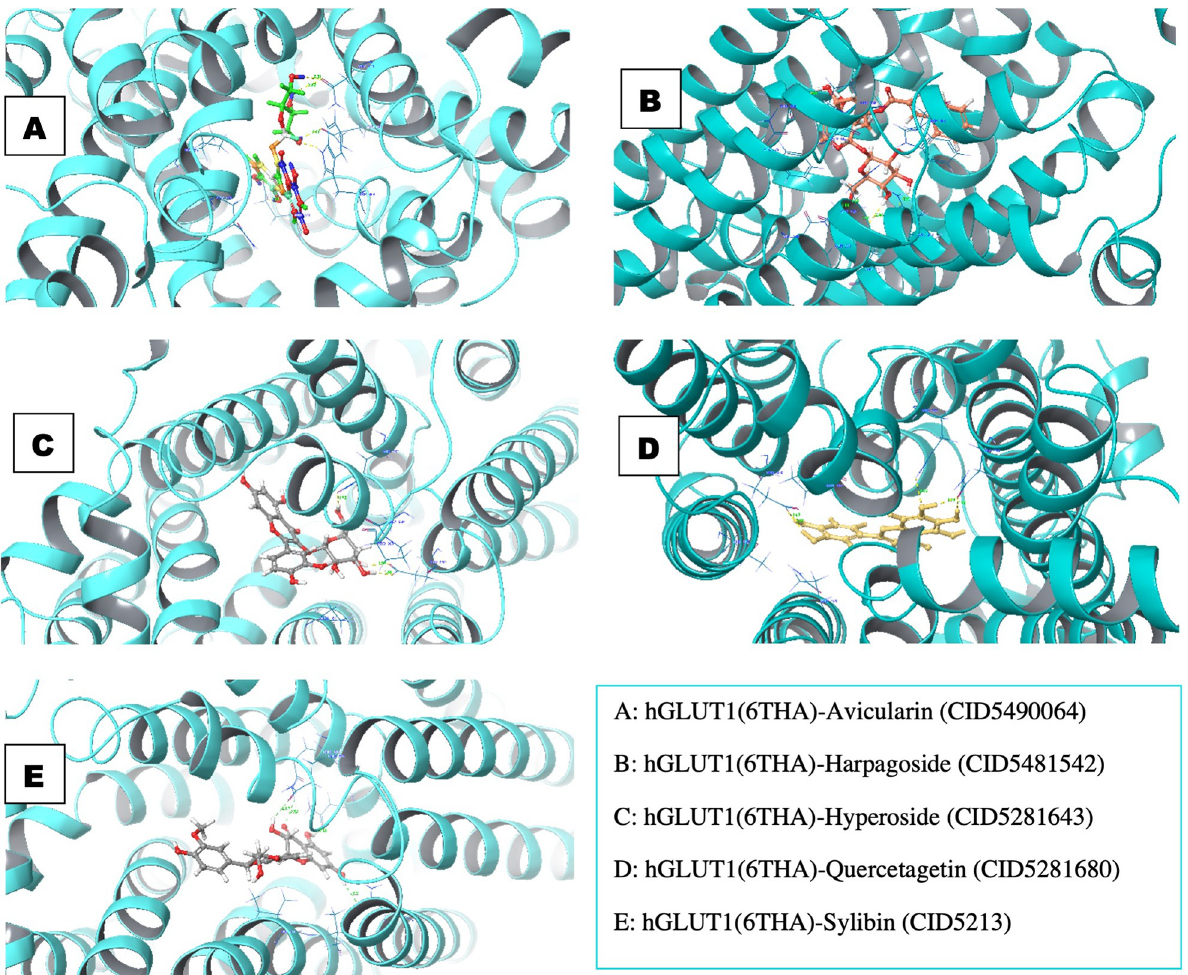
Fig 5. The 3D structures of interaction profile of hGLUT1(6THA)–ligand complexes after molecular docking